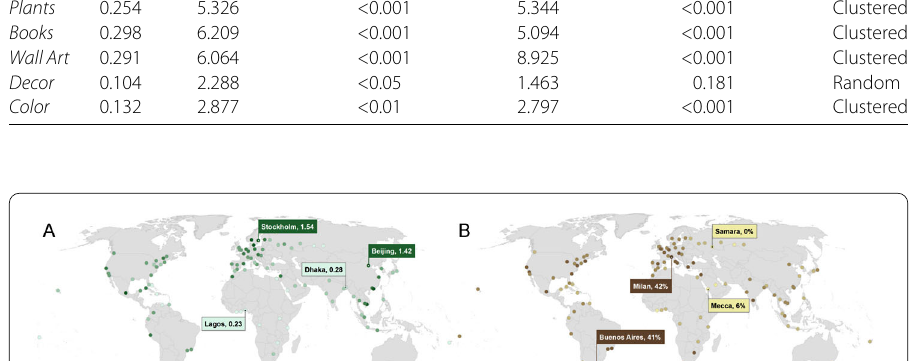
Table 2 Patterning of interior elements across global cities (Moran’s I) and between regions (ANOVA) Element Moran’s I Moran’s I Z-score Moran’s I P-value ANOVA F Statistic ANOVA P-Value Pattern Plants 0.254 5.326 <0.001 5.344 <0.001 Clustered Books 0.298 6.209 <0.001 5.094 <0.001 Clustered WallArt 0.291 6.064 <0.001 8.925 <0.001 Clustered Decor